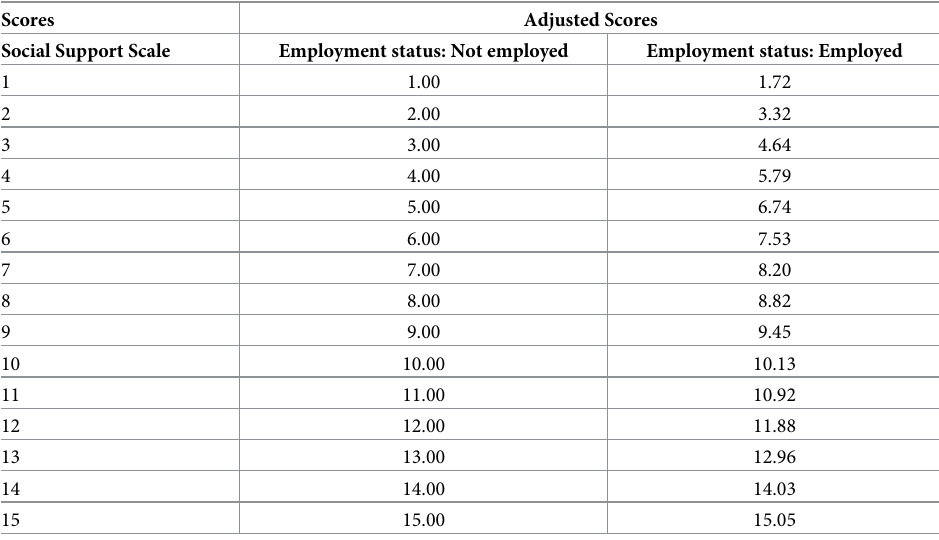
Note. The table indicates conversion values for comparison among subgroups. For example, if an Aboriginal respondent not employed had on the SSS an observed total score of 10, the score should be adjusted to the new (adjusted) total score of 10.13. Values for extreme total scores (0 and 16) are not